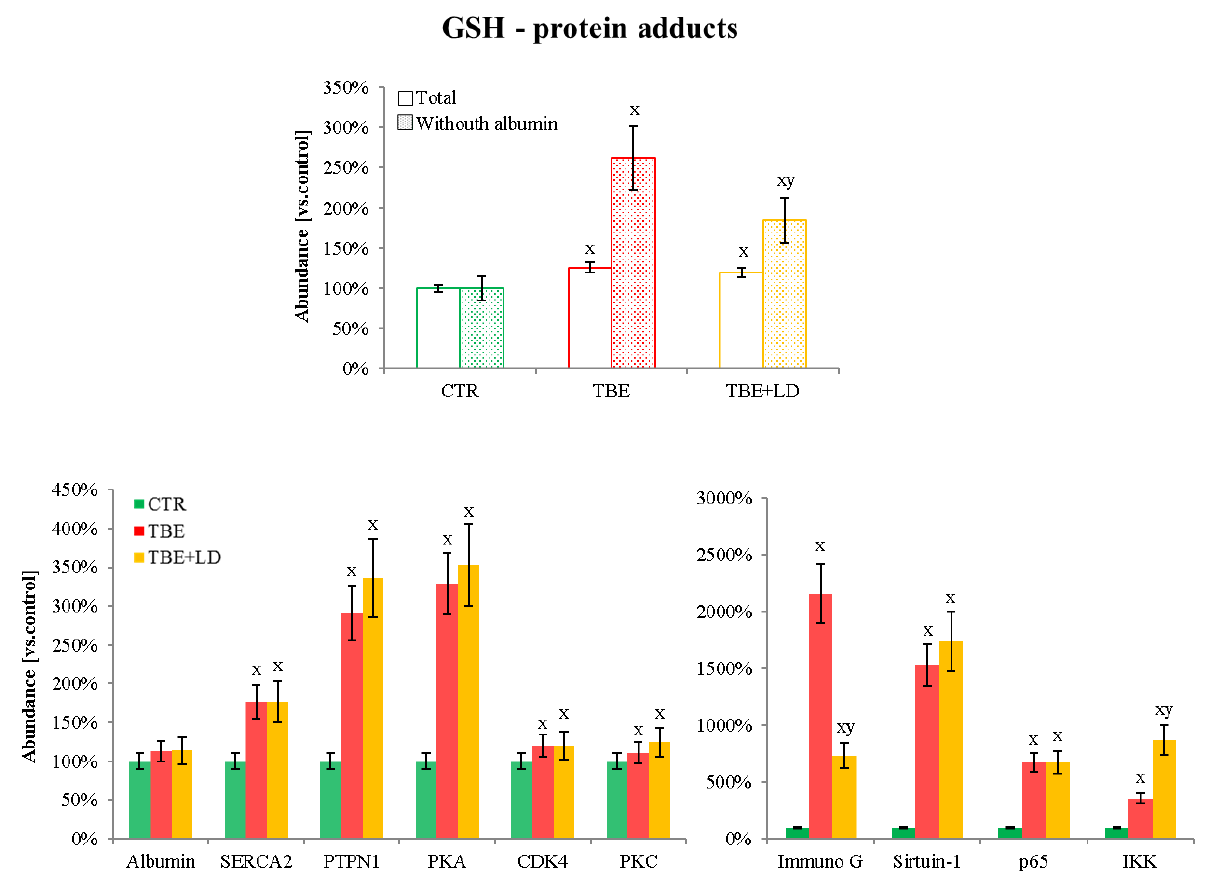
Figure 6. The level of protein modification by glutathione (GSH) in the plasma samples of the control group (CTR, n = 8), patients with tick-borne encephalitis (TBE, n = 16), and patients with TBE and co-infection (TBE+LD, n = 5). Mean values ± SD are presented. x statistically significant differences vs. CTR, p < 0.05; y statistically significant differences vs. TBE, p < 0.05.